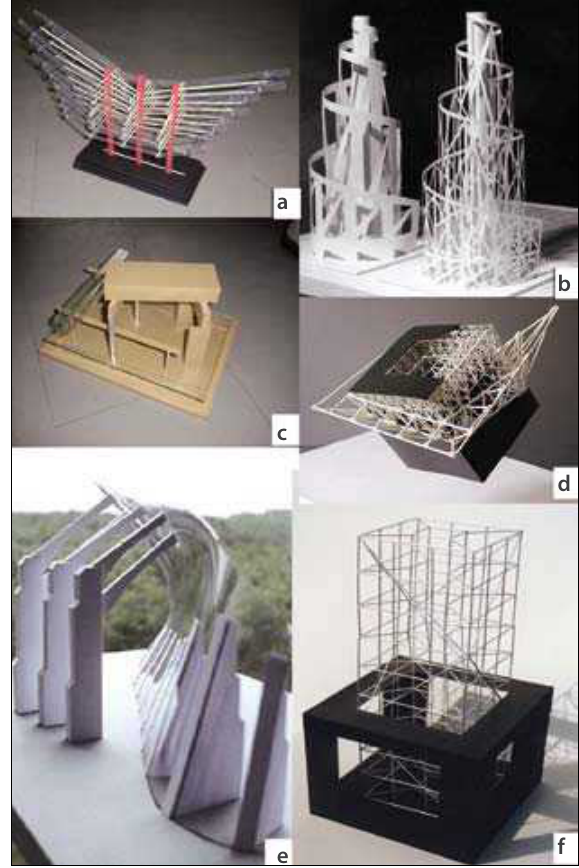
Fig. 5. Examples of students’ works. Intermediate study year: a, c – f – architectural tectonics (VGTU); b – study of architec- tural context and scale